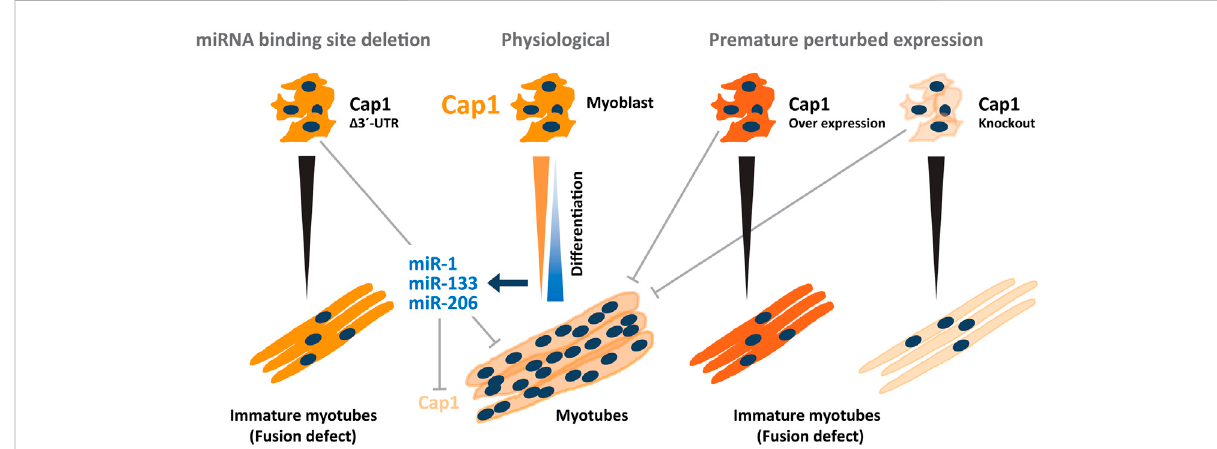
FIGURE 7 Model depicting the regulatory circuitry of myogenic C2C12 differentiation via post-transcriptional Cap1 regulation. Under physiological conditions, a timely and necessary downregulation of the Cap1 during myogenesis, is induced by myogenic miRNAs miR-1a-3p, miR-133a-3p, and miR-206-3p whose expression increases manifold during differentiation. The decreased levels of CAP1 increases the F-actin levels that enable myoblasts for elongation, migration and fusion necessary for the myoblasts fusion and myotube maturation. Under experimental conditions, bothattheinducedoverexpressionandknockoutscenario(ontherightside)adecreasedfusionindexwasobservedasmeasuredbythethicknessof themyotubes aswell asthenumber ofthenuclei presentinthemyosinheavy chain positivemyotubes.Endogenousdeletion ofthe Cap1 3 ′ UTR(on the left side) also resulted in the diminished fusion index similar to the CAP1 overexpressing myoblast. Overall, a timely decrease in the expression of the CAP1 is necessary for myoblast